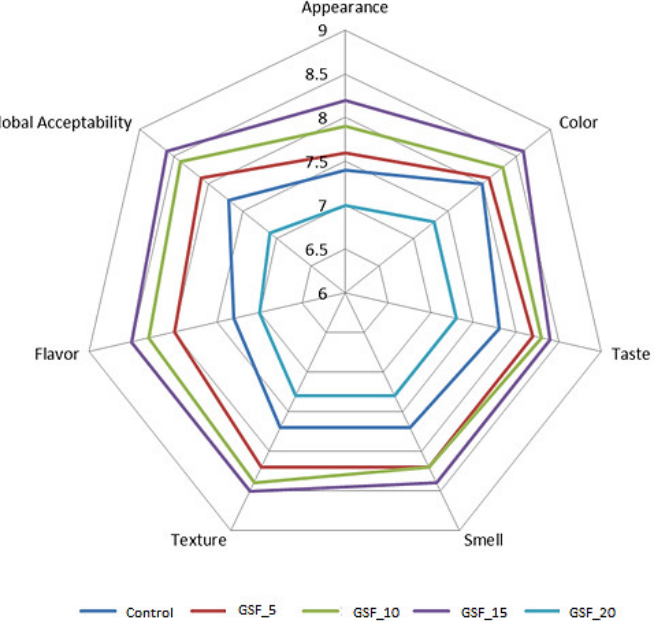
Figure 4. Sensory analysis for bread samples.